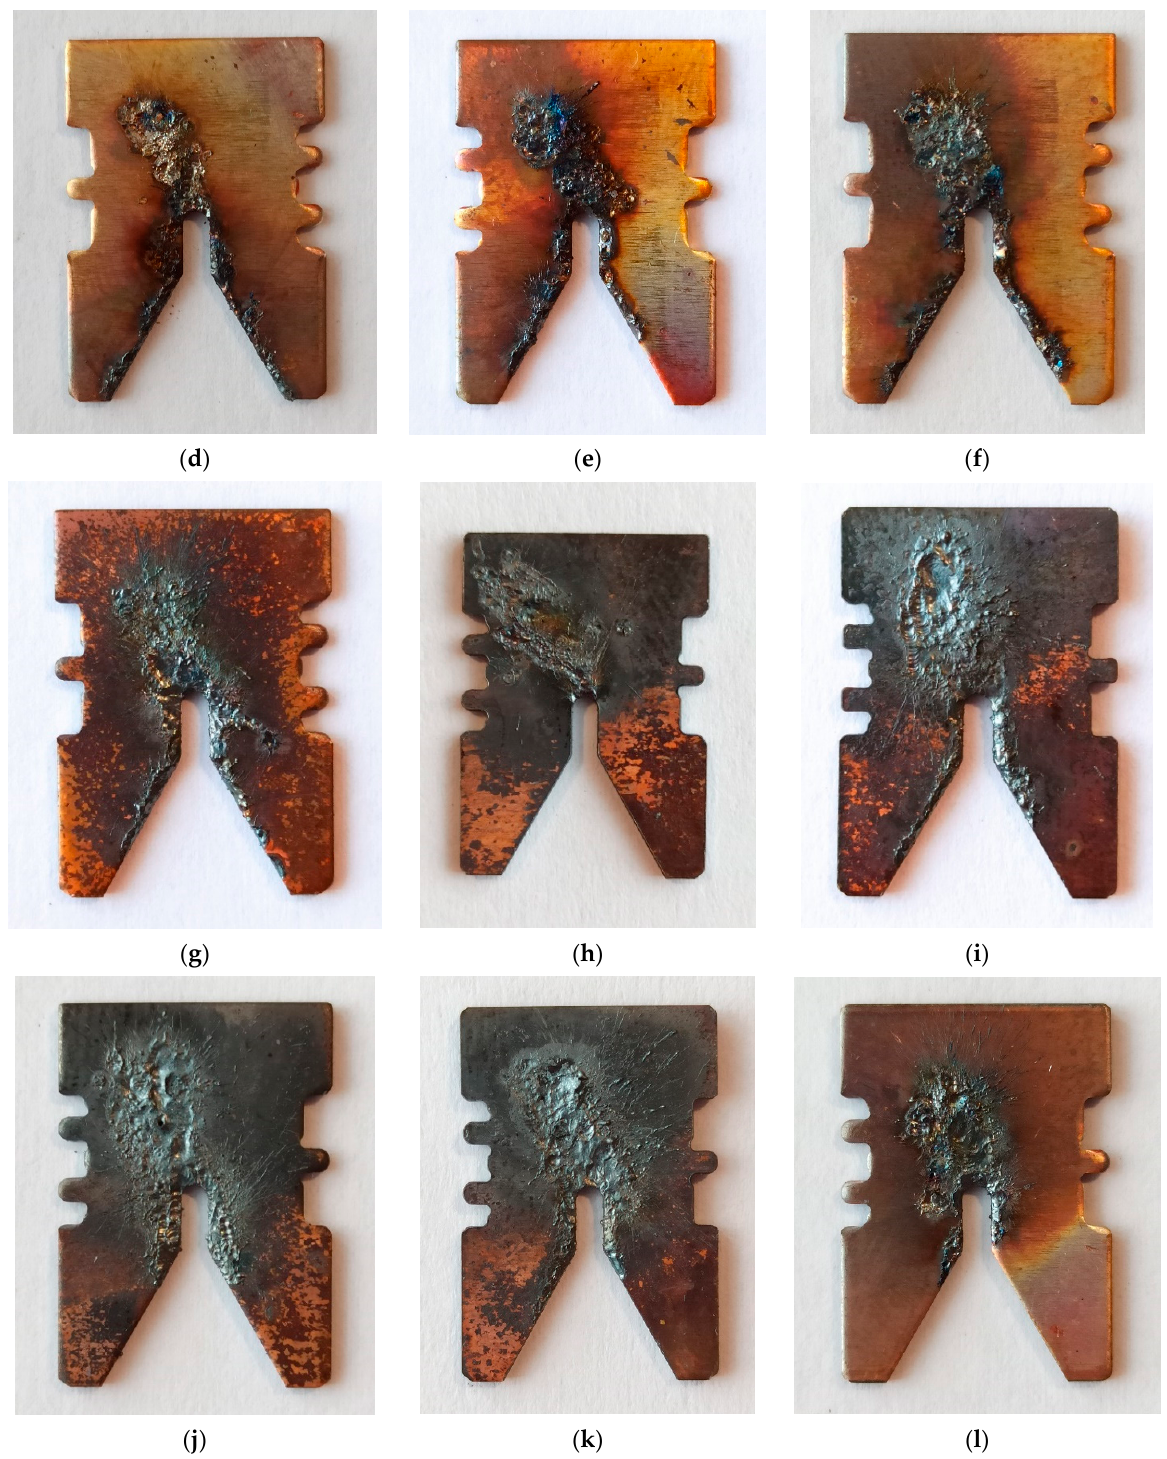
Figure 16. The plates of the extinguishing chamber of the tested circuit breaker with the visible effect of the electric arc inside the extinguishing chamber. Different cases from ( a – l ).